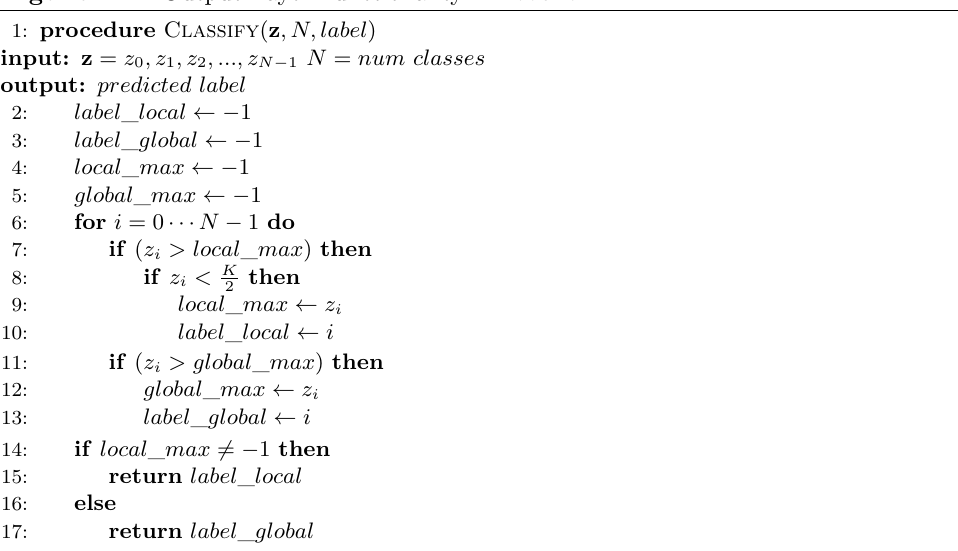
Algorithm 1 Output Layer Functionality in